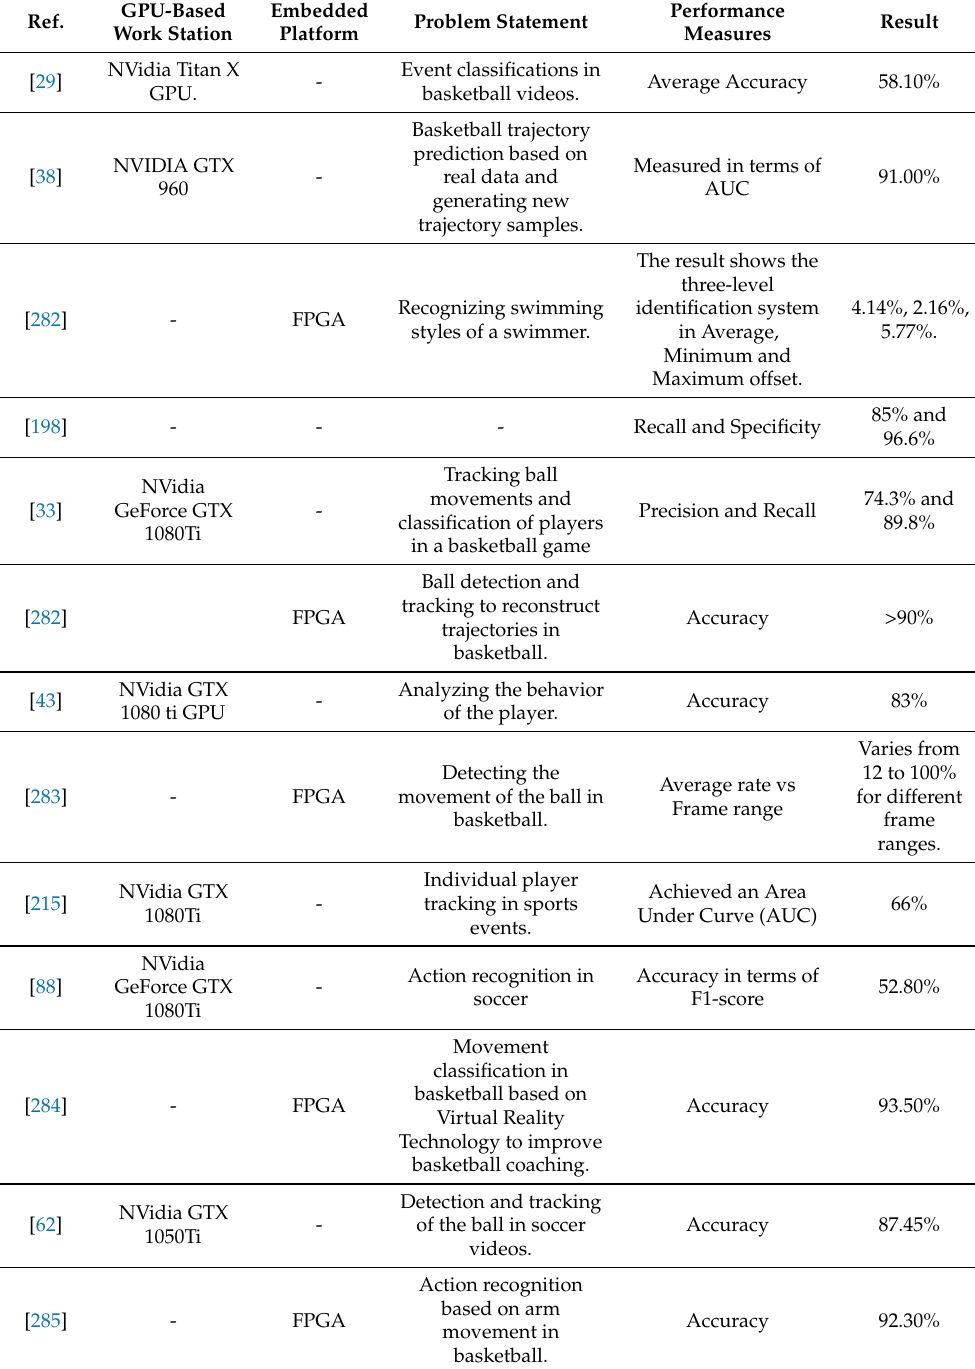
Table 12. Performance of various studies on hardware platforms.